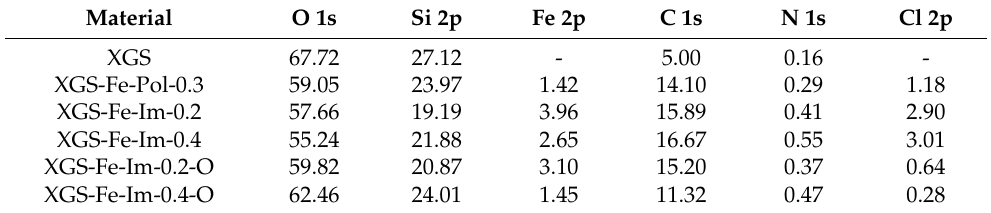
Table 3. Chemical composition of the surface obtained by XPS analysis, all quantities in percentage.